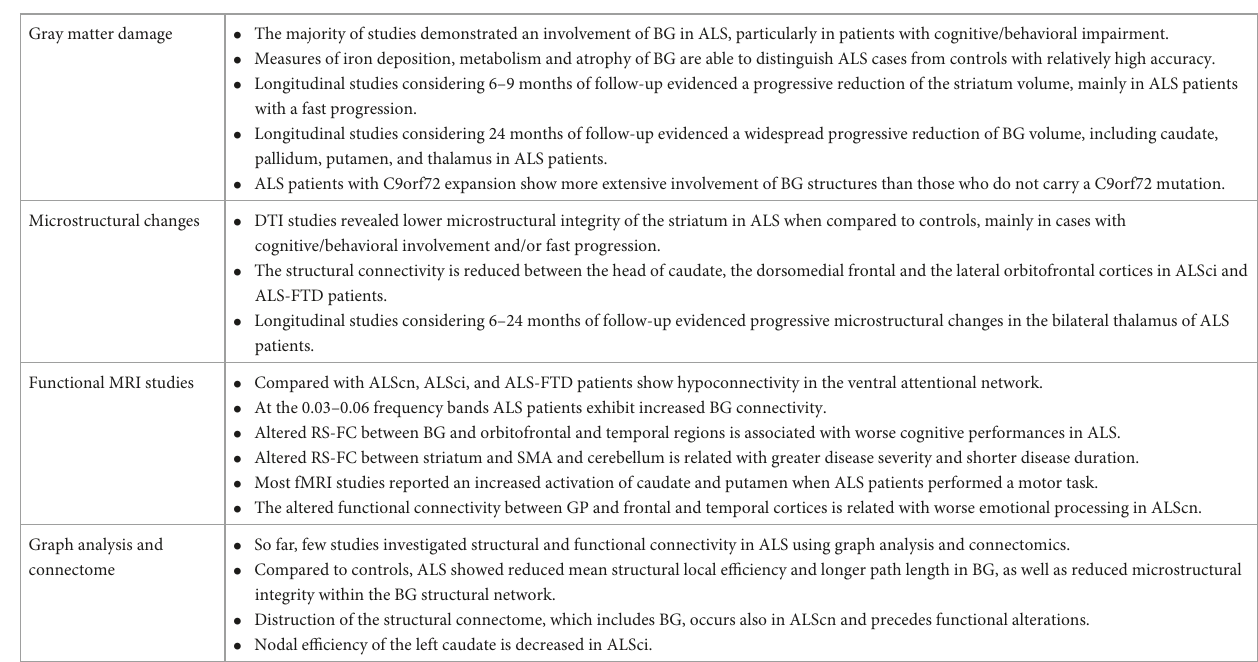
TABLE 1 Highlights of the